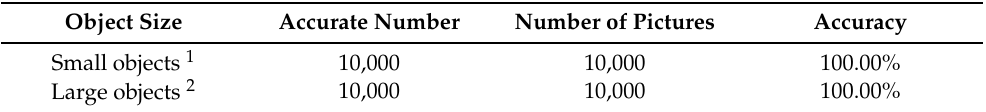
Table 1. Noise-free accuracy of artificial visual